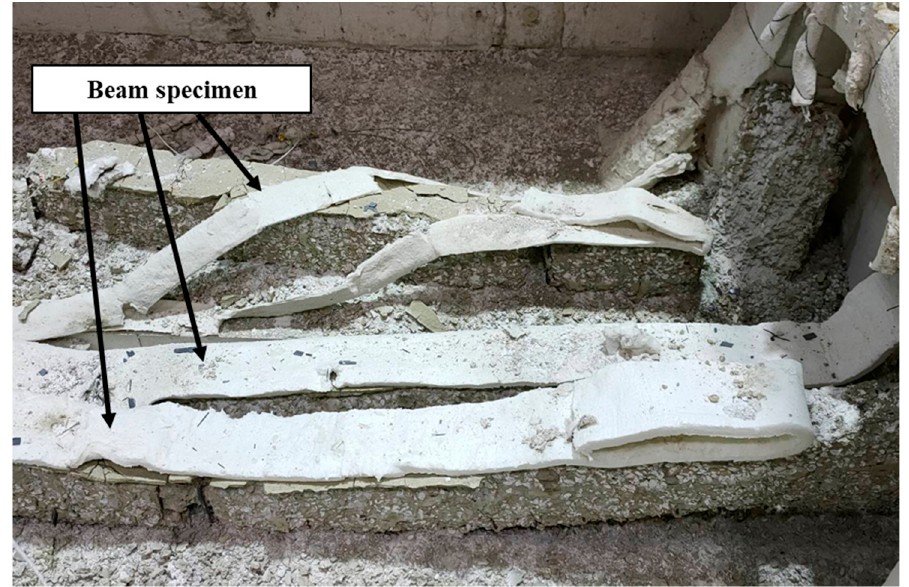
Figure 11. Failure of beams subject to fire.